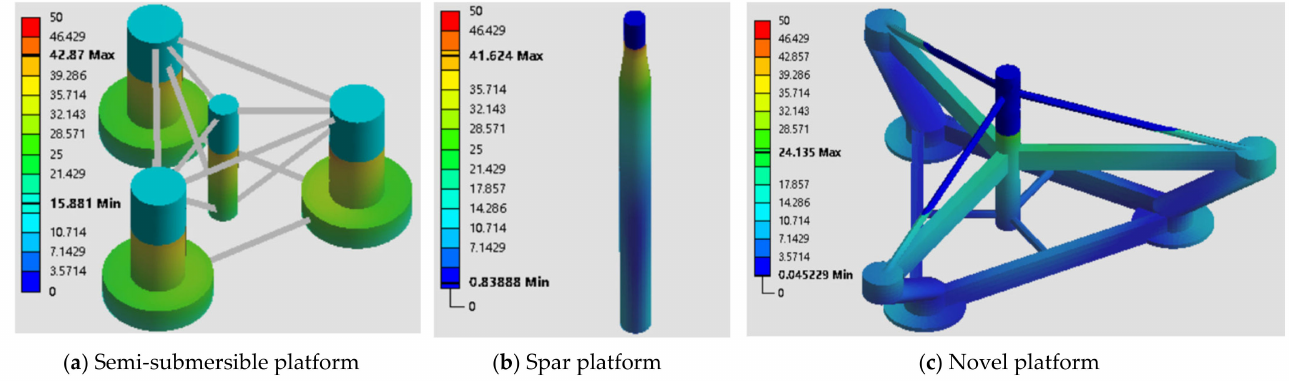
Figure 17. Surface pressure distribution of three floating